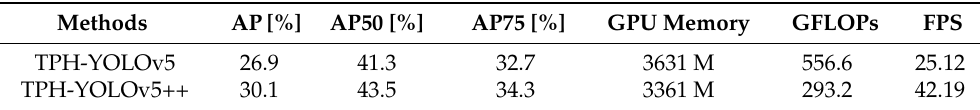
Table 6. Ablation study of TPH-YOLOv5 and TPH-YOLOv5++ on UAVDT.